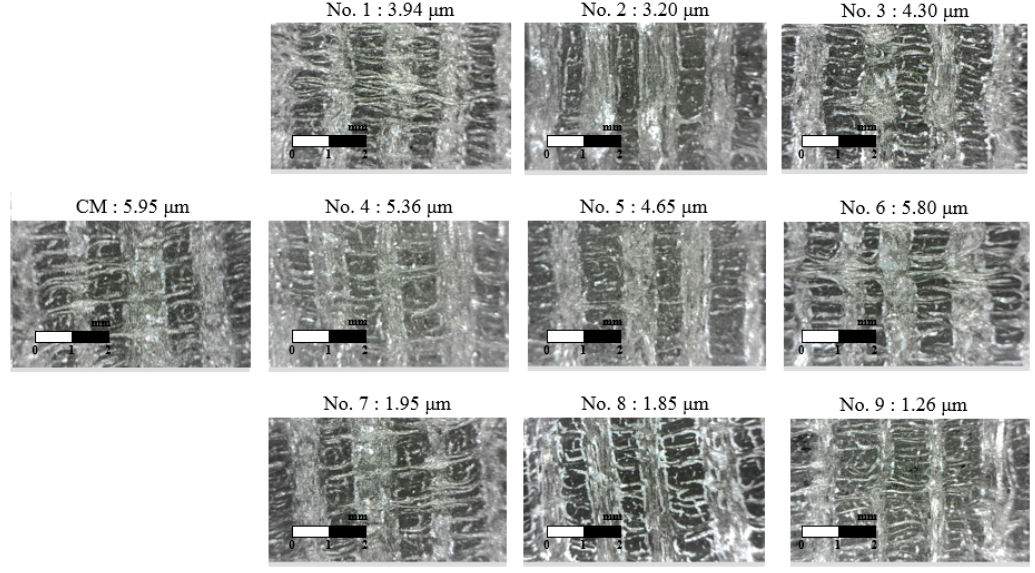
Figure 7. The microphotographs of machined surfaces of C / SiC composite material in LAM. Table 6. The experimental data value of cutting force and surface roughness.